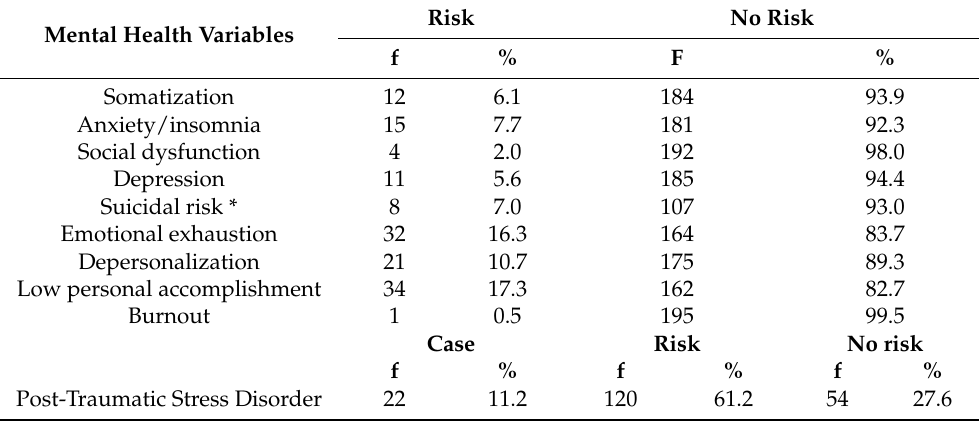
Table 2. Prevalence of mental